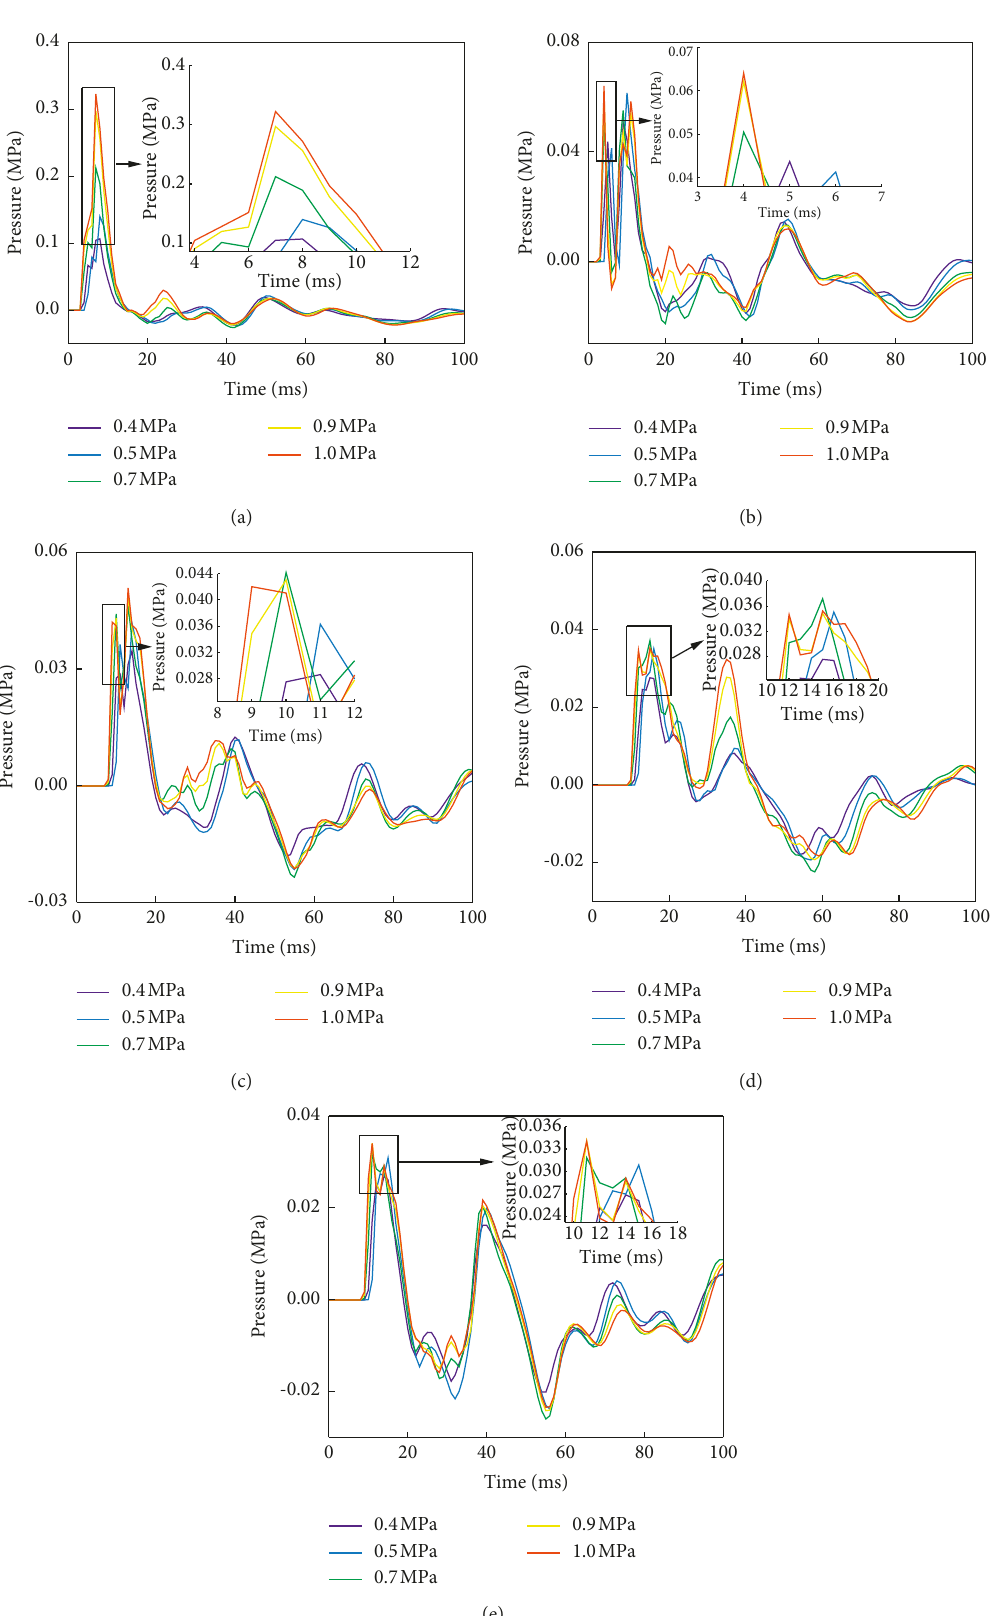
Figure 4: Variation of shock wave overpressure with time. (a) Point No. 1. (b) Point No. 2. (c) Point No. 3. (d) Point No. 4. (e) Point No.